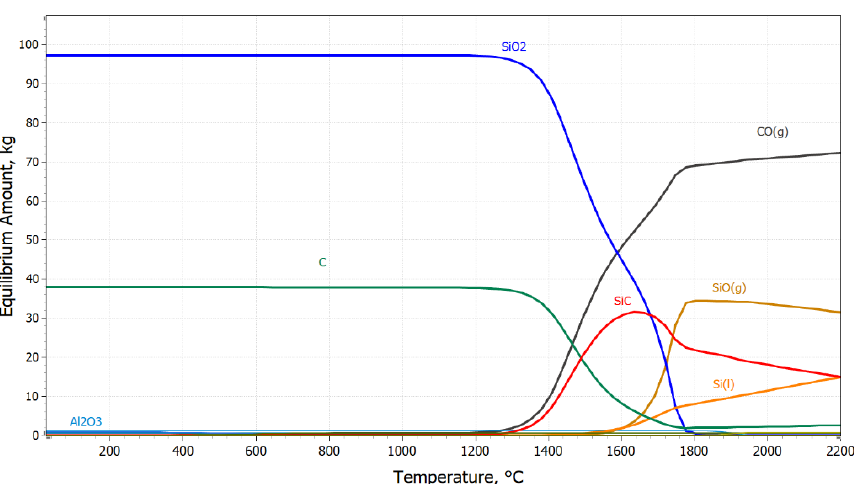
Figure 10. Gibbs equilibrium diagram of carbothermic reduction of quartzite Slovakia at the stoichiometric amount of reductant.